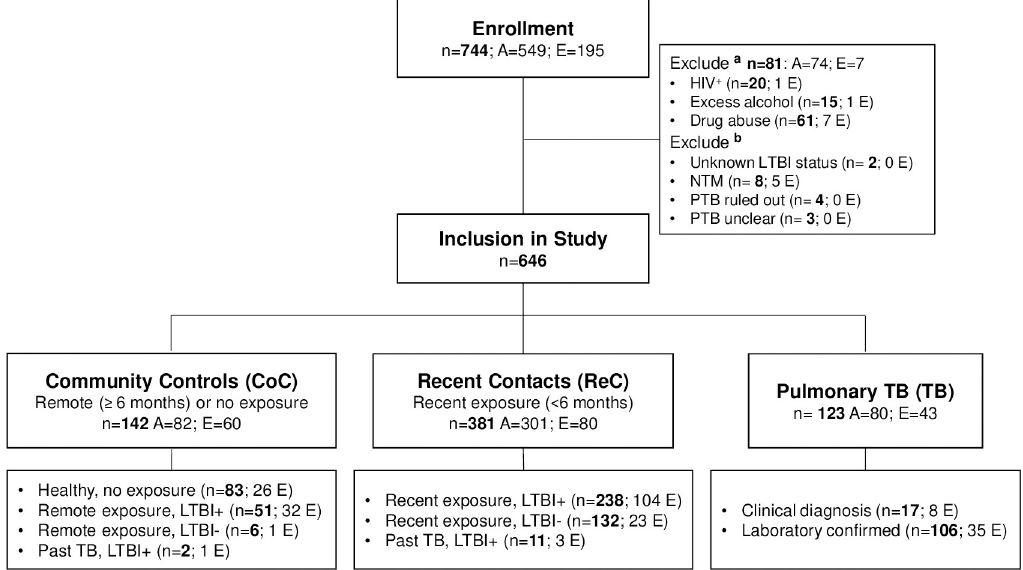
Fig 1. Enrollment algorithm. Adults (A) and elderly (E) individuals identified in the community (Community controls, CoC), or in pulmonary clinics as newly-diagnosed pulmonary TB patients (TB), or contacts of TB cases with reported exposure � 6 months before enrollment (Recent contacts, ReC), were invited to participate. TB diagnosis was based on laboratory findings (positive culture and/or acid-fast sputum smear) or clinical criteria based on physician diagnosis and abnormal chest X-ray. LTBI, Latent TB infection. a Exclusion based on HIV infection, excessive alcohol use, and drug abuse, with some having more than one of these conditions. b Exclusion due to unknown LTBI status, non-tuberculosis mycobacteria (NTM) or pulmonary TB diagnosis ruled out/unclear.